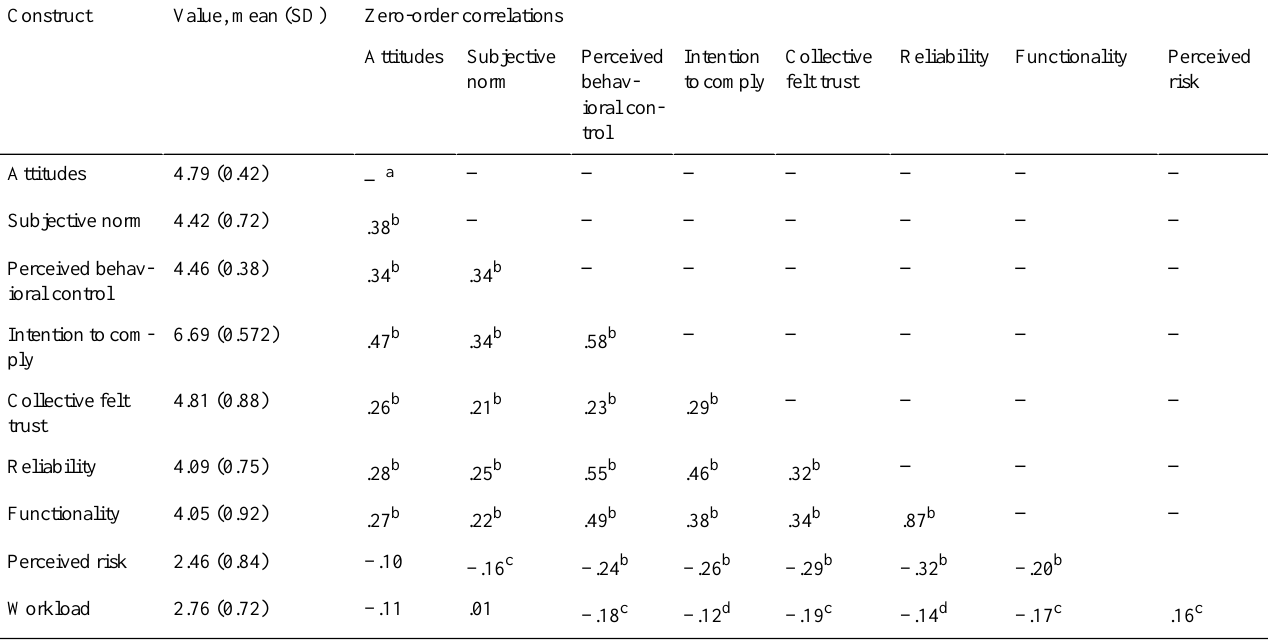
Table 5. Zero-order correlations and descriptive statistics.